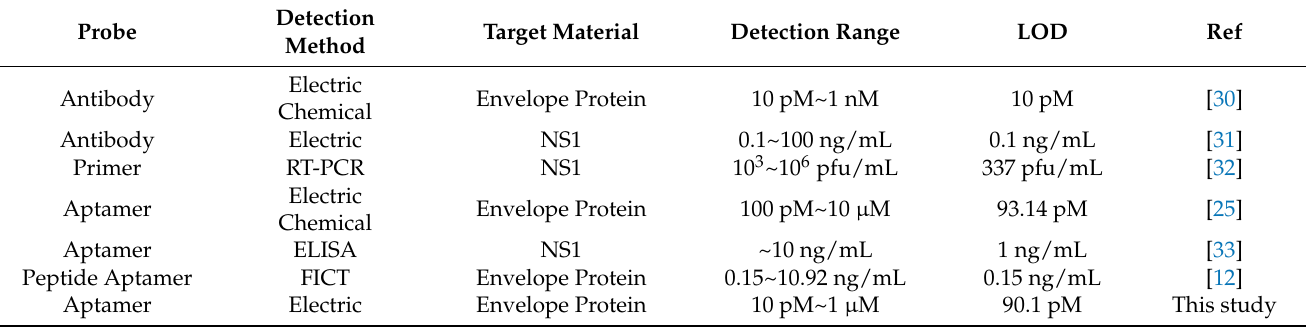
Table 1. Biosensor comparison table for zika virus